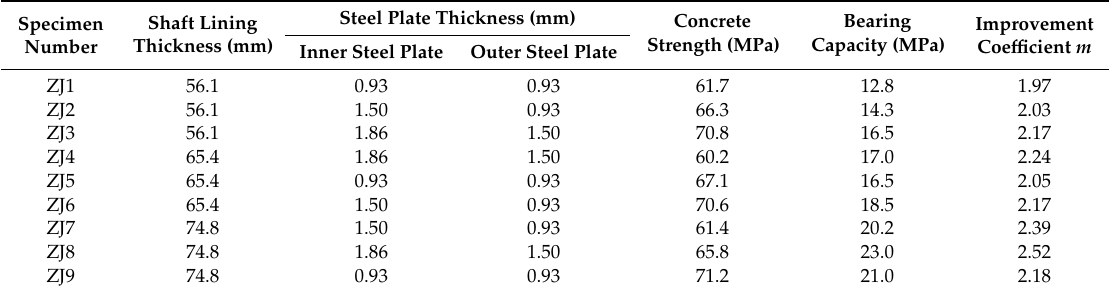
Table 3. Model specimen loading